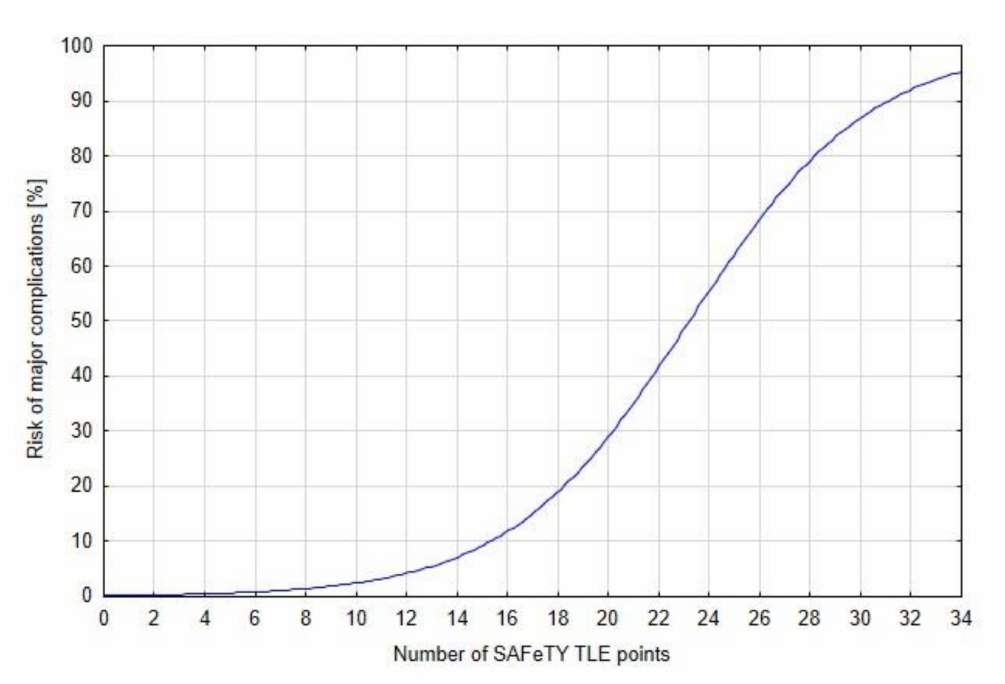
Figure 2. SAFeTY TLE algorithm—dependency between the risk score and the risk of major complications, results for 2049 TLE procedures. Logistic equation for the occurrence of major complications (%) = 100 / (1 + 644 / (1.3213 x